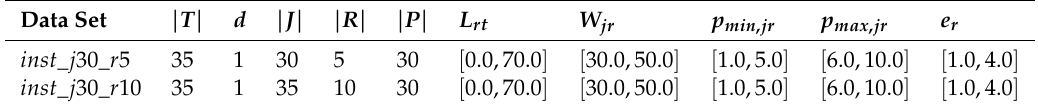
Table 7. Instance dataset